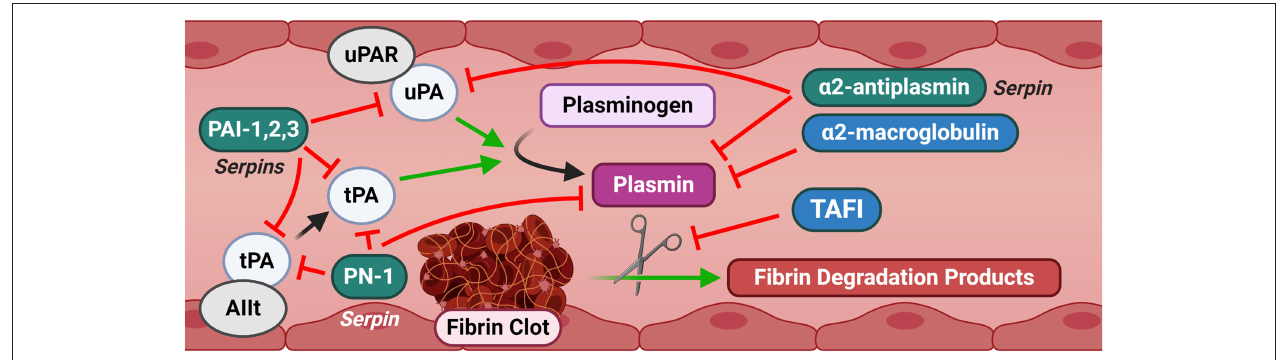
FIGURE 3 | Canonical signaling of the fibrinolysis pathway. Fibrinolysis is characterized by the degradation of a fibrin clot into degradation products by plasmin. Plasmin is generated from plasminogen by uPA and tPA. Several serpins and other inhibitors provide a tight regulation of this cascade. Substantial promiscuity exists across multiple elements of the pathway, providing redundant controls against inappropriate activation. AIIt and uPAR are shown as representative canonical fibrinolytic receptors for brevity. AIIt, Annexin II tetramer; PAI-1,2,3, Plasminogen Activator Inhibitor-1, 2, 3; PN-1, Protease Nexin-1; TAFI, Thrombin activatable fibrinolysis inhibitor; tPA, Tissue-type plasminogen activator; uPA, Urokinase-type plasminogen activator; uPAR, Urokinase-type plasminogen activator